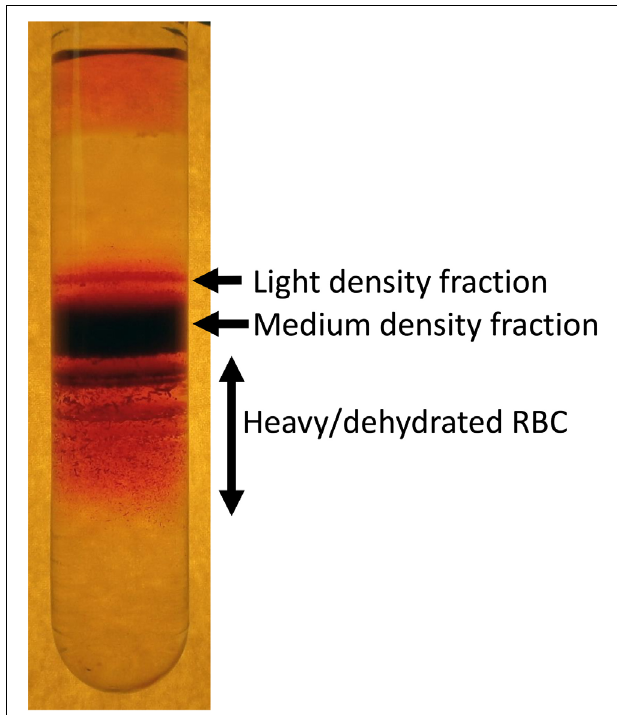
FIGURE 1 | An example of heterogeneity of RBC density revealed by fractionation of RBCs on a self-forming Percoll density gradient. Composition of light, medium and high-density fractions vary depending on human health and environmental stress. About 15–20% of RBCs of healthy human donors forming low density are reticulocytes. However, along with young cells this fraction is “contaminated” with swollen RBCs at the terminal senescence stage (Lew and Tiffert, 2013). Medium fraction is formed by mature RBCs, and heavy dehydrated cells are those with senescent